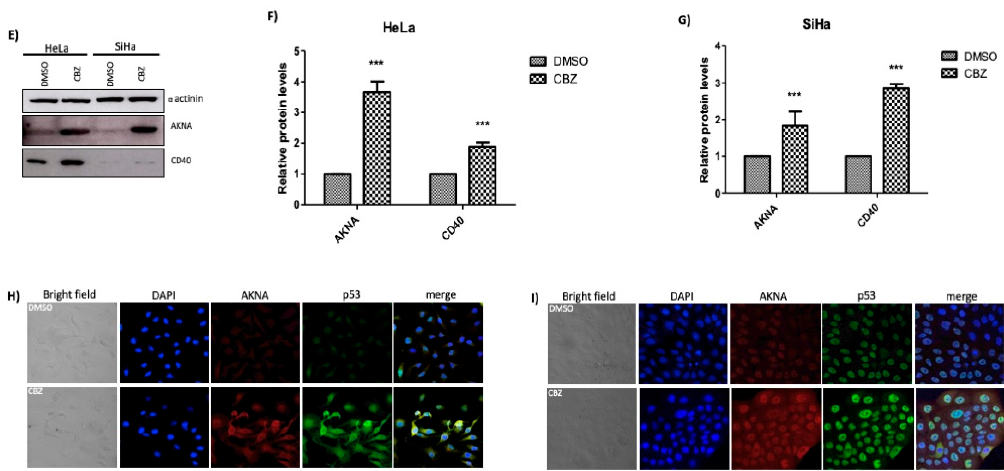
Figure 3. HPV E6 oncoproteins regulate AKNA levels. ( A ) HaCaT cells were transfected with plasmids expressing HA-tagged versions of HPV16 and 18 E6 oncoproteins, 24 h after transfection, cells were collected, and protein extracted by adding sample buffer. The levels of AKNA were ascertained by western blot using AKNA anti-serum. Anti-HA antibody was used to determine the expression of the HPV E6 oncoproteins. E6 expressing cells show a clear reduction in AKNA levels 24 h post-transfection compared with the control vector (pCA). These results demonstrate that E6 is able to regulate AKNA protein levels. ( B ) Densitometric analysis expressing data as the ratio of relative units between AKNA and GAPDH. Data are shown as the mean ± SD. Tukey’s test * p < 0.05 and ** p < 0.005 vs.